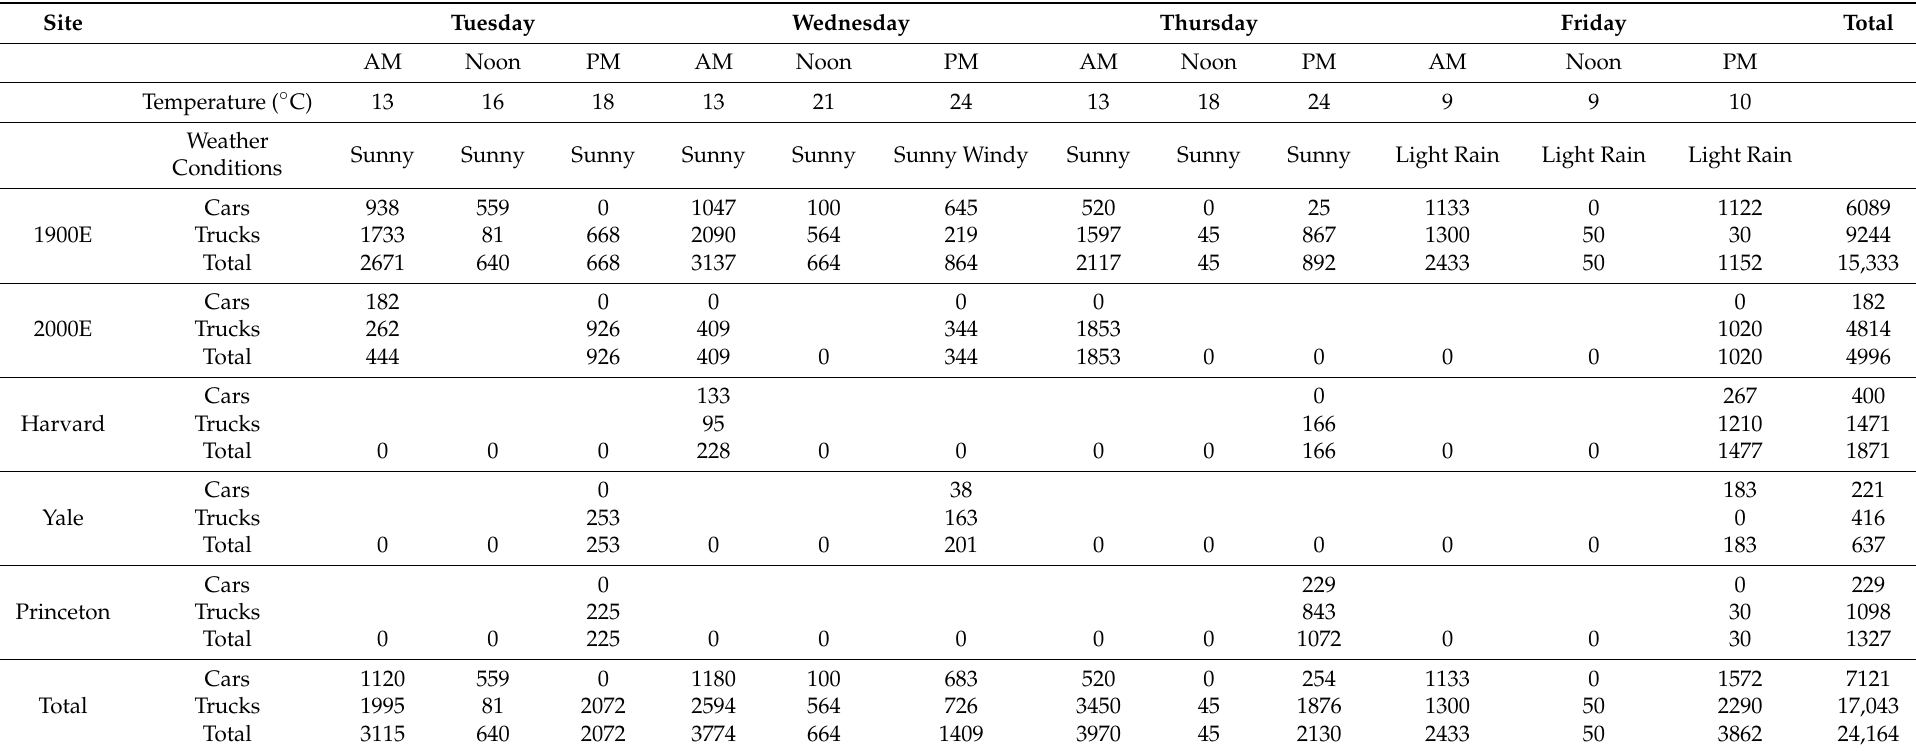
Table 9. Idling time (seconds) during the pre-intervention week: 17–20 September